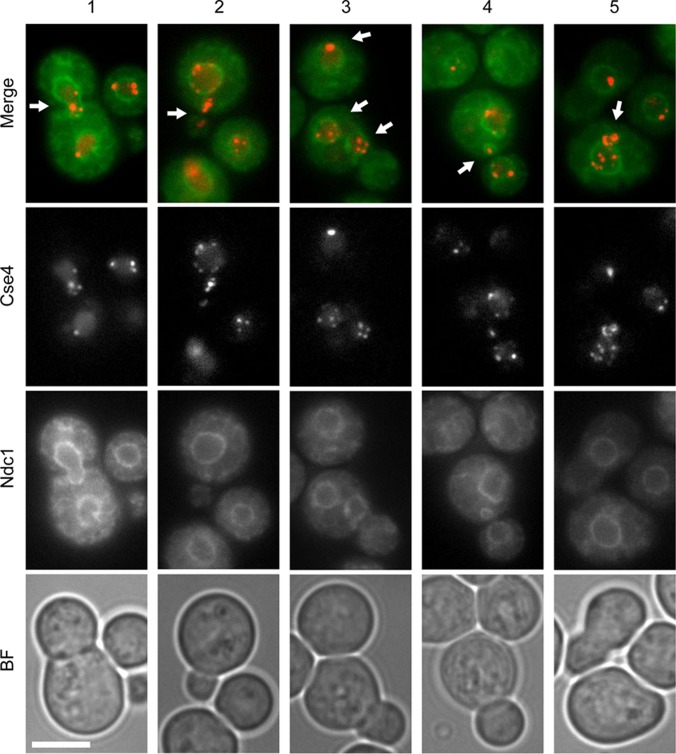
Analysis of centromere dynamics in FLC-treated cells. A strain that expressed a fluorescently tagged centromeric histone variant, mCherry-Cse4, and a component of the nuclear envelope, GFP-Ndc1 (CNV111), was subjected to treatment with 32 μg/ml FLC for 13 and 15 h prior to imaging. Panels 1 to 5 depict representative types of aberrations in Cse4 dynamics, including centromeres positioned at the mother-bud neck (panels 1 and 4, arrows), clustered centromeres in unbudded cells or cells with small daughters (panels 2 and 3), two nuclei present in one mother cell (panel 3), and centromeres that appear outside the nuclear area (panels 2 and 5). Bar, 5 µm.